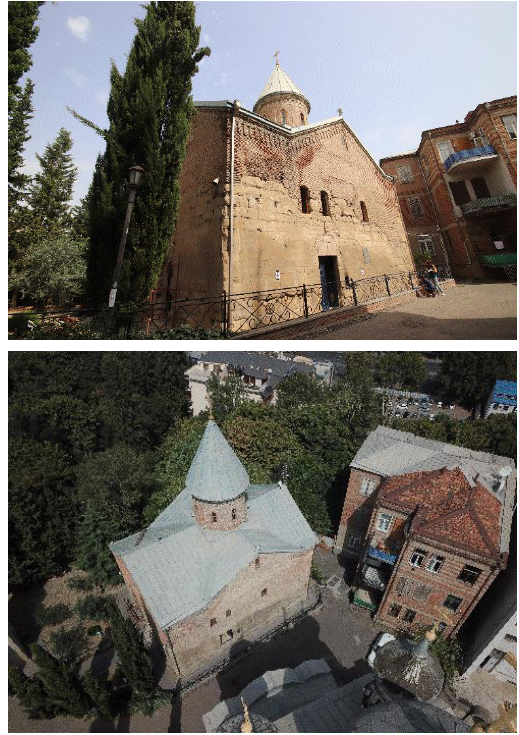
Figure 1. Andreas Church in Lurdji complex